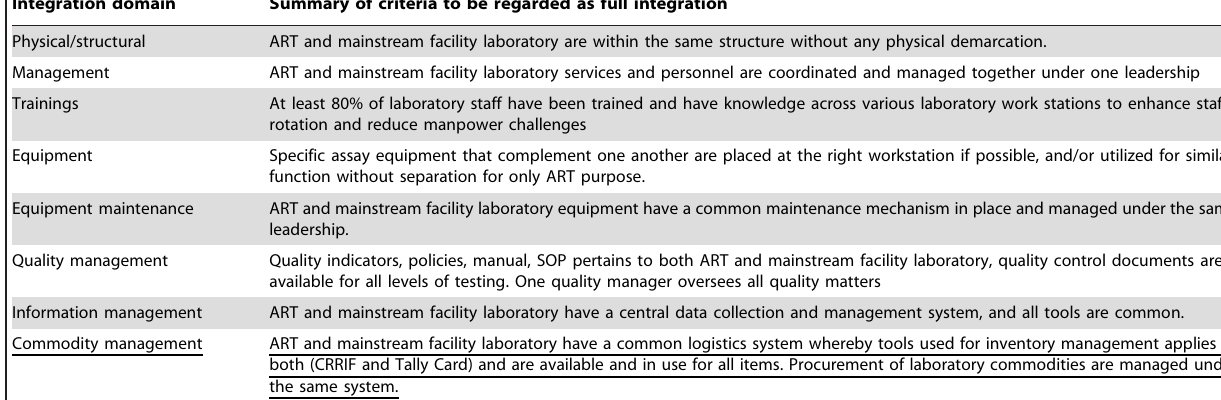
Table 1. Guidelines for scoring at